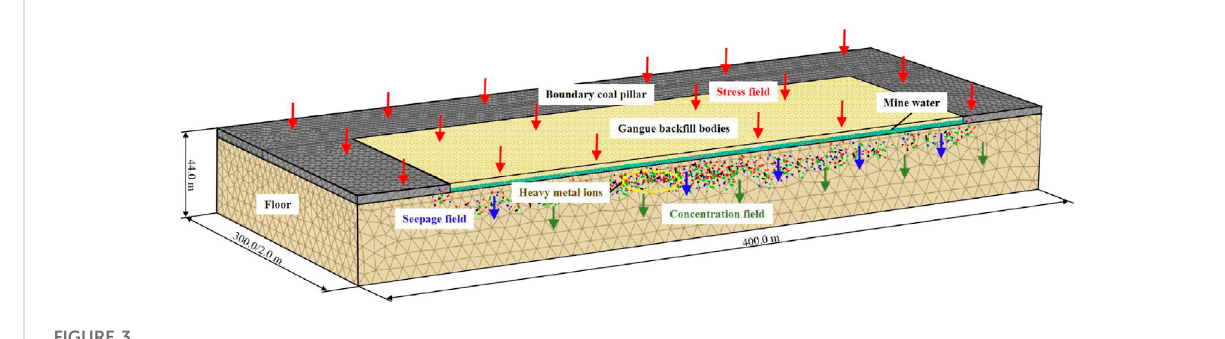
FIGURE 3 Numerical